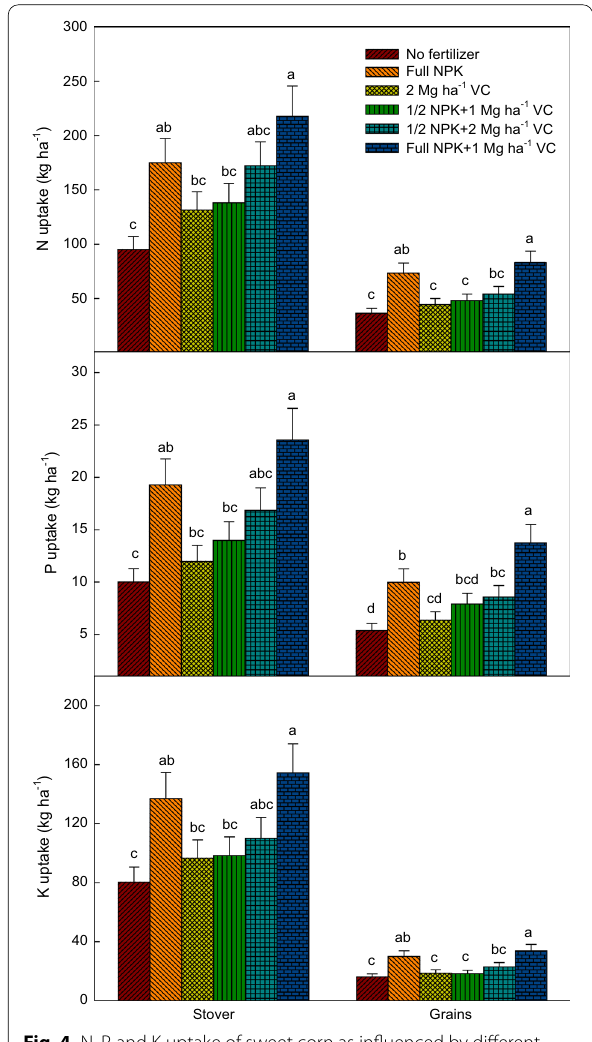
Fig. 4 N, P, and K uptake of sweet corn as influenced by different fertilization. Vertical bars indicate standard deviations (